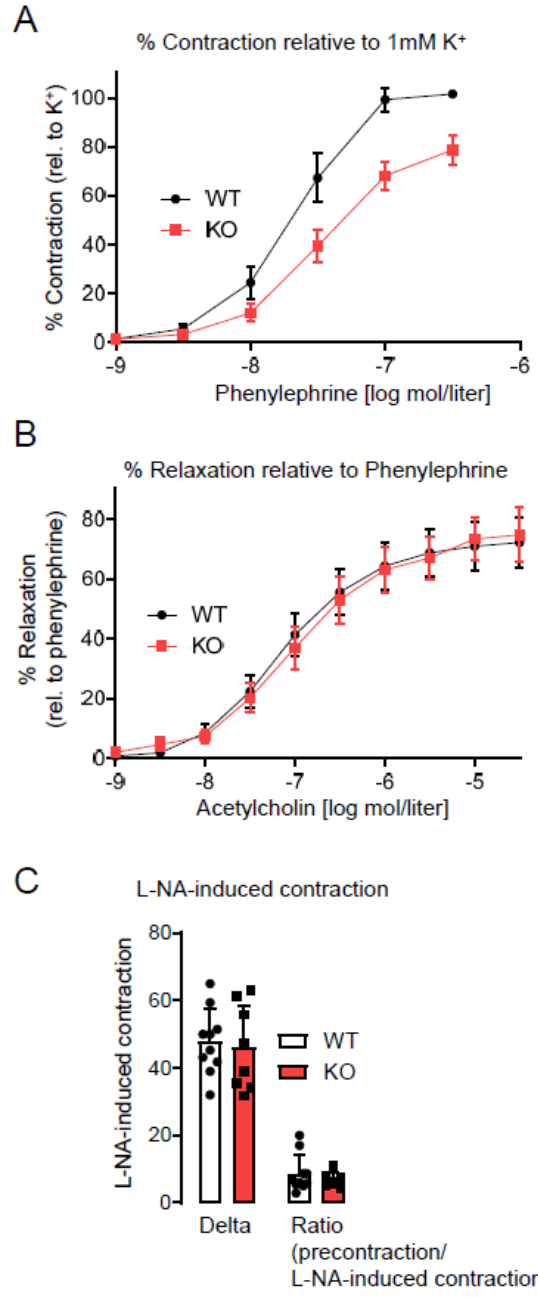
Figure 3. Vessel function with ( A ) contraction in response to phenylephrine and ( B ) relaxation in response to acetylcholine at the concentrations indicated. ( C ) L-NA induced contraction as measure of NO formation. n = 10; male mice at the age of 12 weeks.